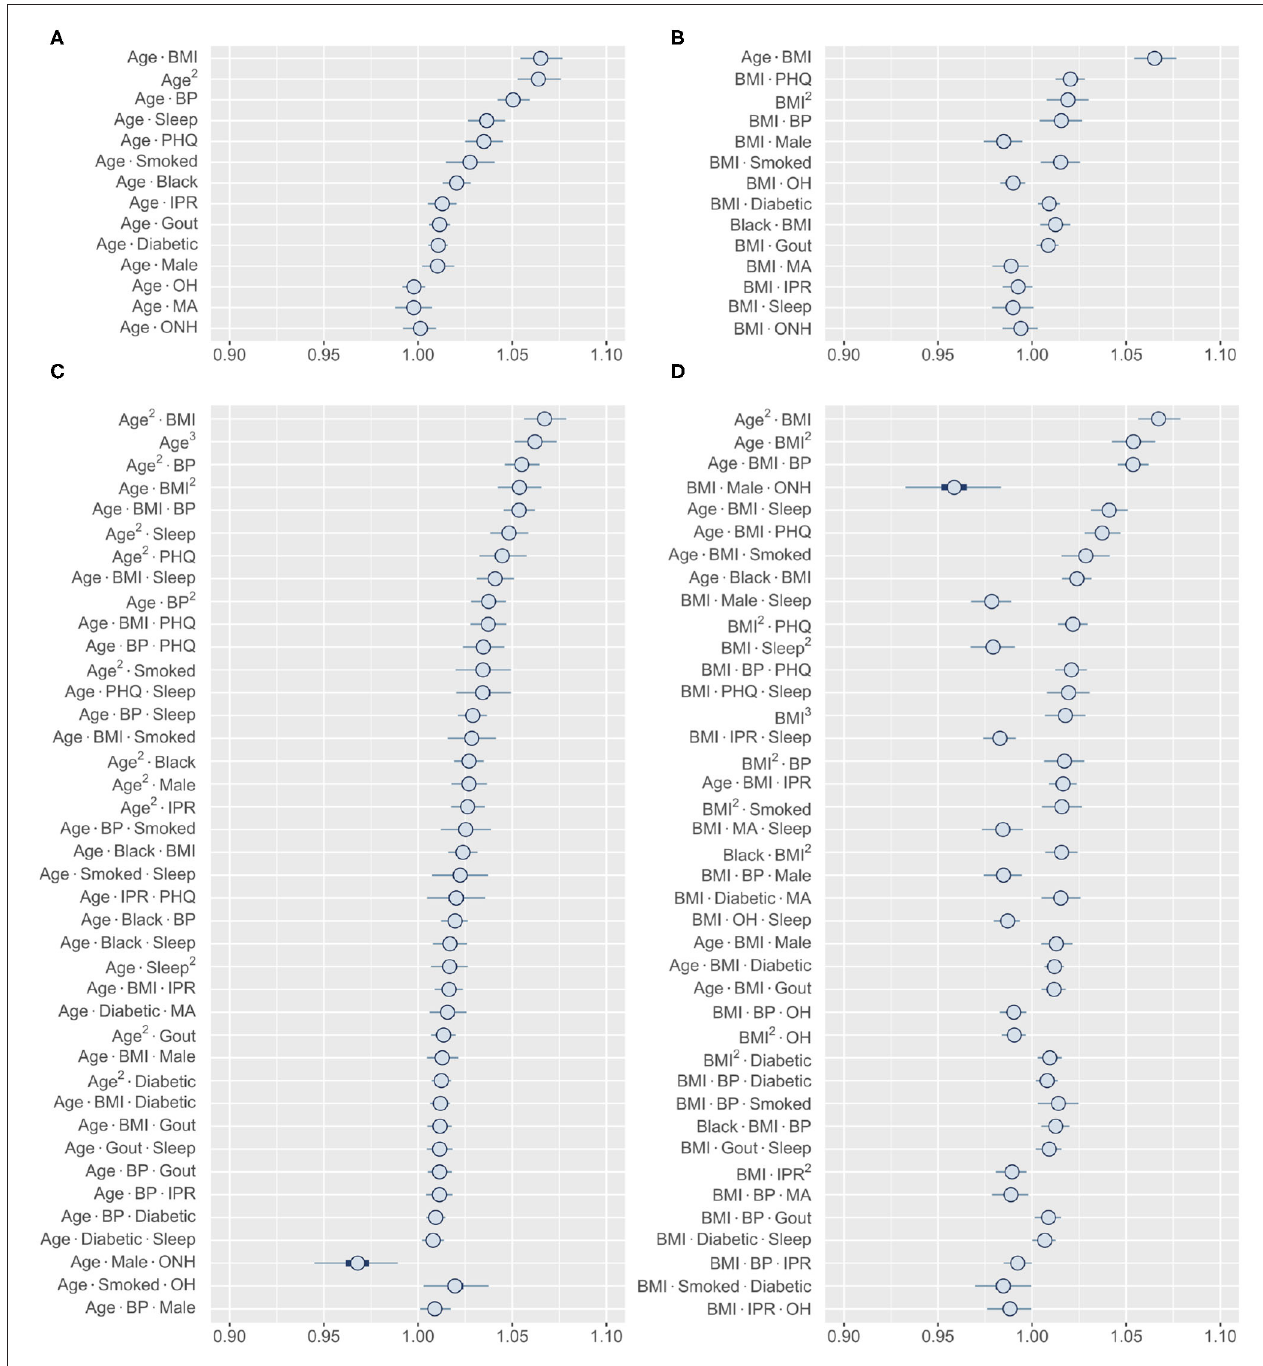
FIGURE 6 | Higher-order interactions of age and BMI. (A,B) Posterior distribution of standardized coefficients for all second-order interactions of age (A) and BMI (B) . (C,D) Posterior distribution of standardized coefficients for a selection of 40 third-order interactions involving age (C) and BMI (D) . Inner bounds and outer bounds represent 50% HDIs and 99% HDIs, respectively. MA, Mexican-American; OH, Other Hispanic; ONH, Other Non-Hispanic. Horizontal scale shows odds multipliers for risk of RA for a one standard deviation increase in value of